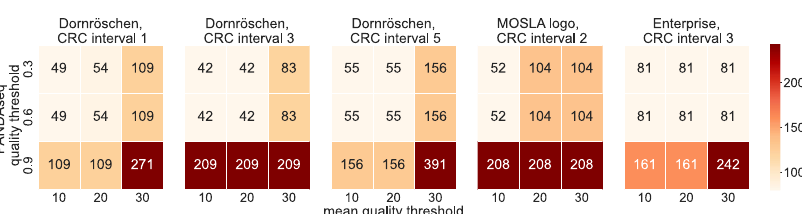
Fig. 5 | Required amount of sequencing reads: the minimal amount of raw sequencing reads, as a multiple of the amount of encoded data, that were required for successful decoding under various raw read processing para- metersandCRCintervals. TheCRCintervalsrepresentthenumberofinformation bytes between two 8-CRCs in the encoded data, the mean quality threshold is the minimalaveragequalityscoreforarawreadtonotbediscardedduringprocessing.